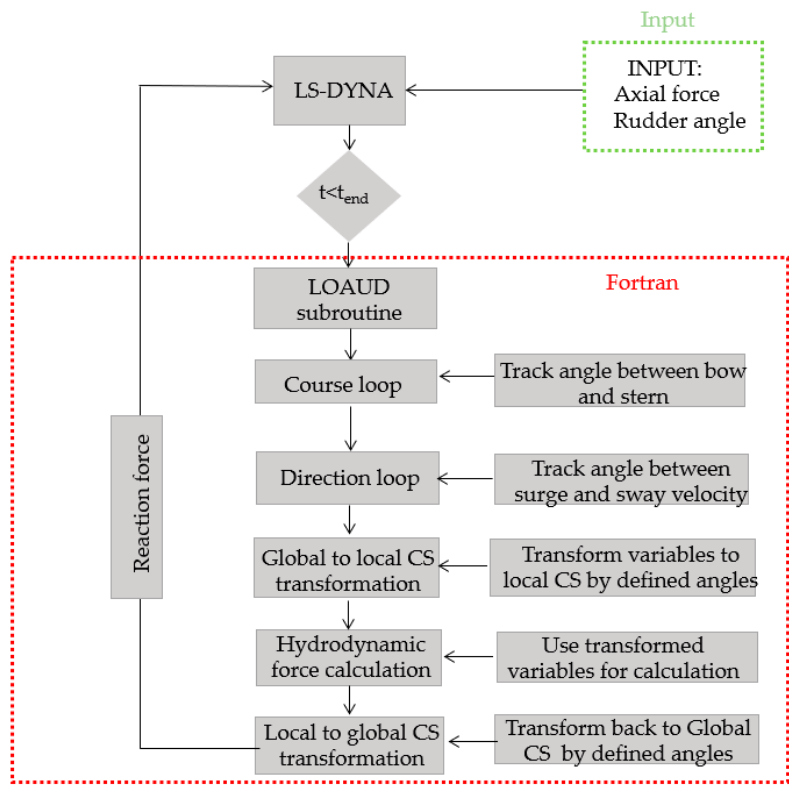
Figure 3. Numerical workflow algorithm.